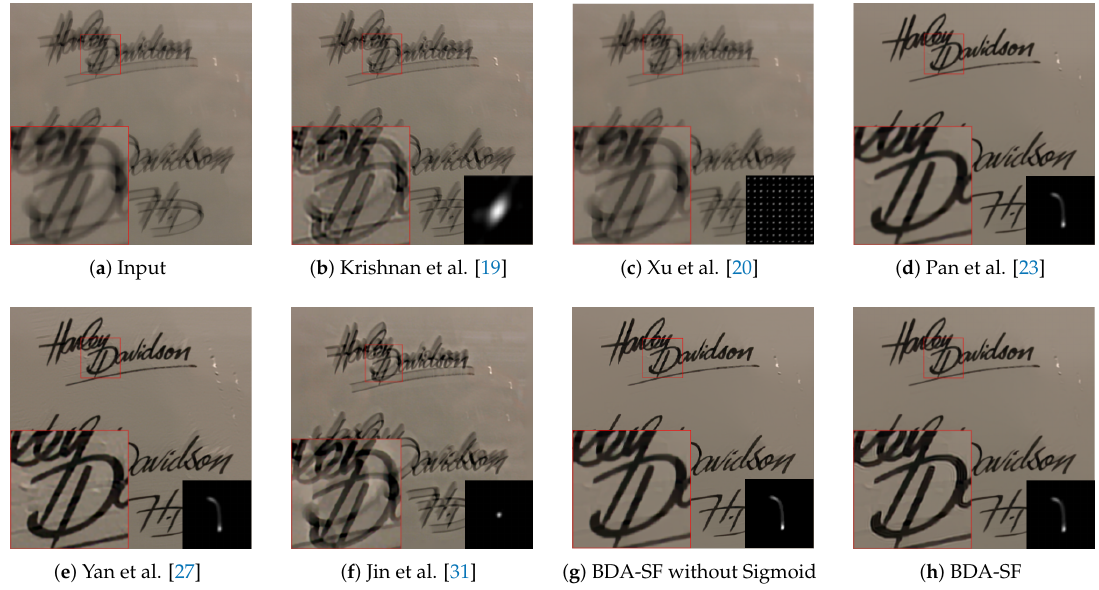
Figure 17. Visual comparison on a text image. BDA-SF achieves comparable visual results with method [23,27]. (Best viewed on high-resolution display with